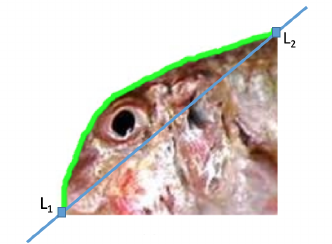
Figure 7. Fragment of interest of the fish delimited by landmarks L 1 and L 2